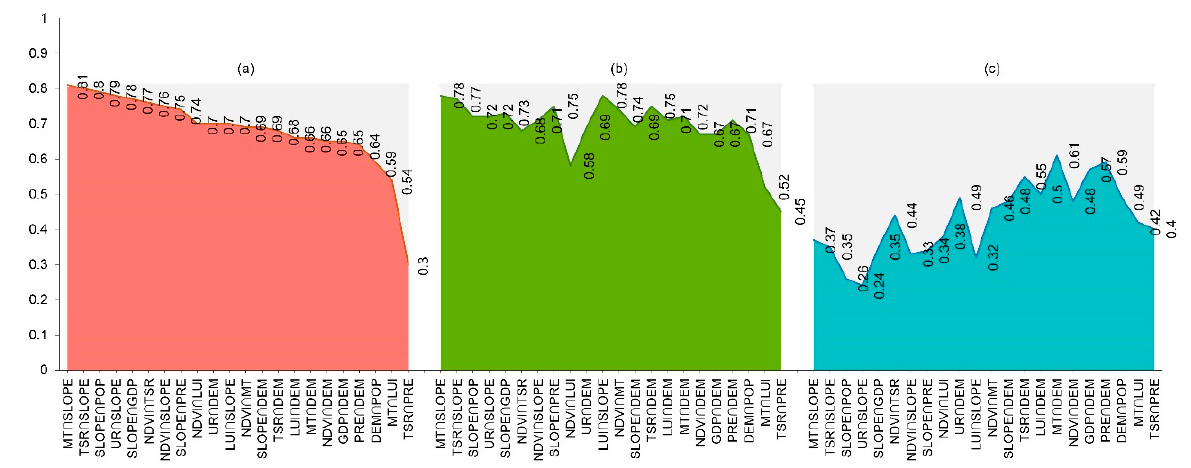
Figure 7. Results of factor interaction in Dalian from 2005 to 2015; ( a ) county scale, ( b ) watershed scale, ( c ) 1 km grid scale.